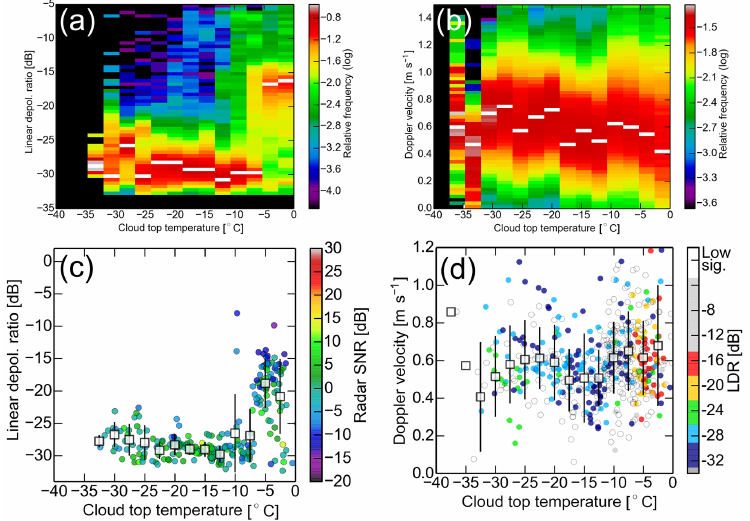
Figure 8. All values of (a) LDR and (b) v CB measured with cloud radar MIRA-35 in the virgae below cloud layers over Leipzig. The visible spread in v CB is due to vertical air motion (see velocity plots in Fig. 3). Averaged values for the individual cloud cases are depicted in (c, d) respectively. Maximum values in each column are marked with white